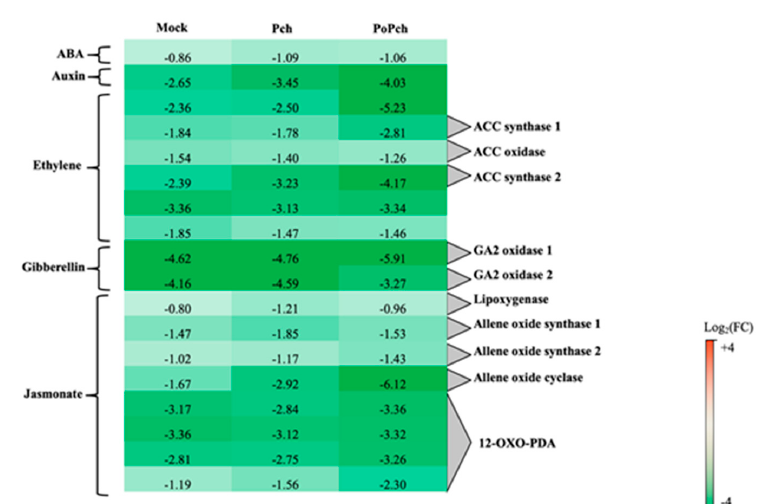
Figure 4. Characteristics of the grapevine transcriptome evolution for genes involved in hormone biosynthesis pathways between 0- and 14-dpi. Expression level values of genes encoding proteins involved in the synthesis or regulation of hormones ( ABA : abscisic acid, ACC : 1-aminocyclopropane overexpression at 14-dpi and the green color means overexpression at 0-dpi. Mock: mock